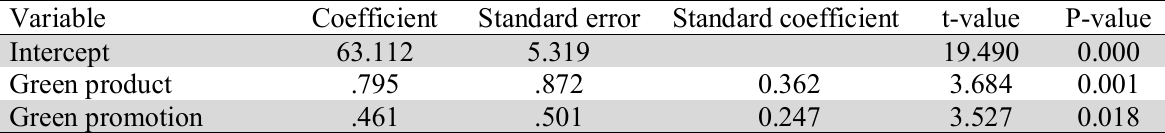
The summary of stepwise regression